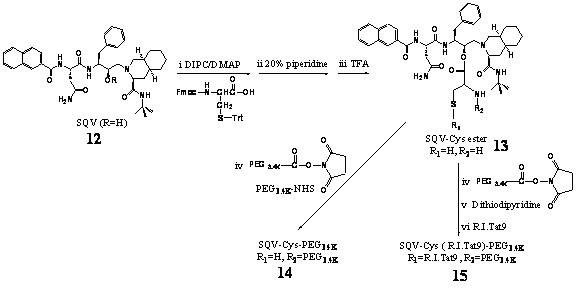
Synthetic scheme of Tat-SQV bioconjugates (i) 3 equivalents Fmoc-Cys(S-Trt)-COOH in CH2Cl2 with DIPC/DMAP; (ii) 20% piperidine in CH2Cl2 ; (iii) TFA/CH2Cl2 (1:1); (iv) 2 equivalents Fmoc-PEG3.4 K-NHS in CH2Cl2 with DIEA; (v) 2 equivalents 2,2'-Dithiodipyridine in DMSO; (vi) 2 equivalents. R.I.CK-Tat9 in DMSO.